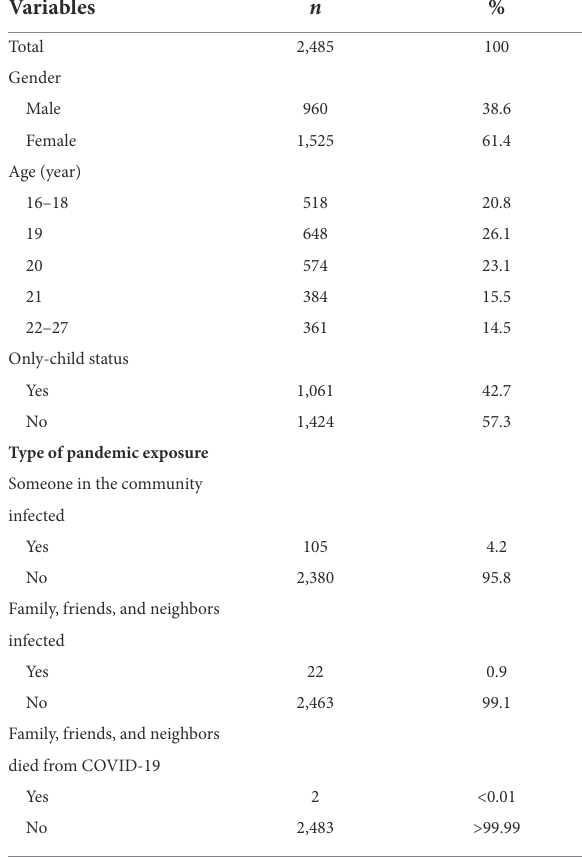
TABLE 1 Demographic and exposure variables ( N =